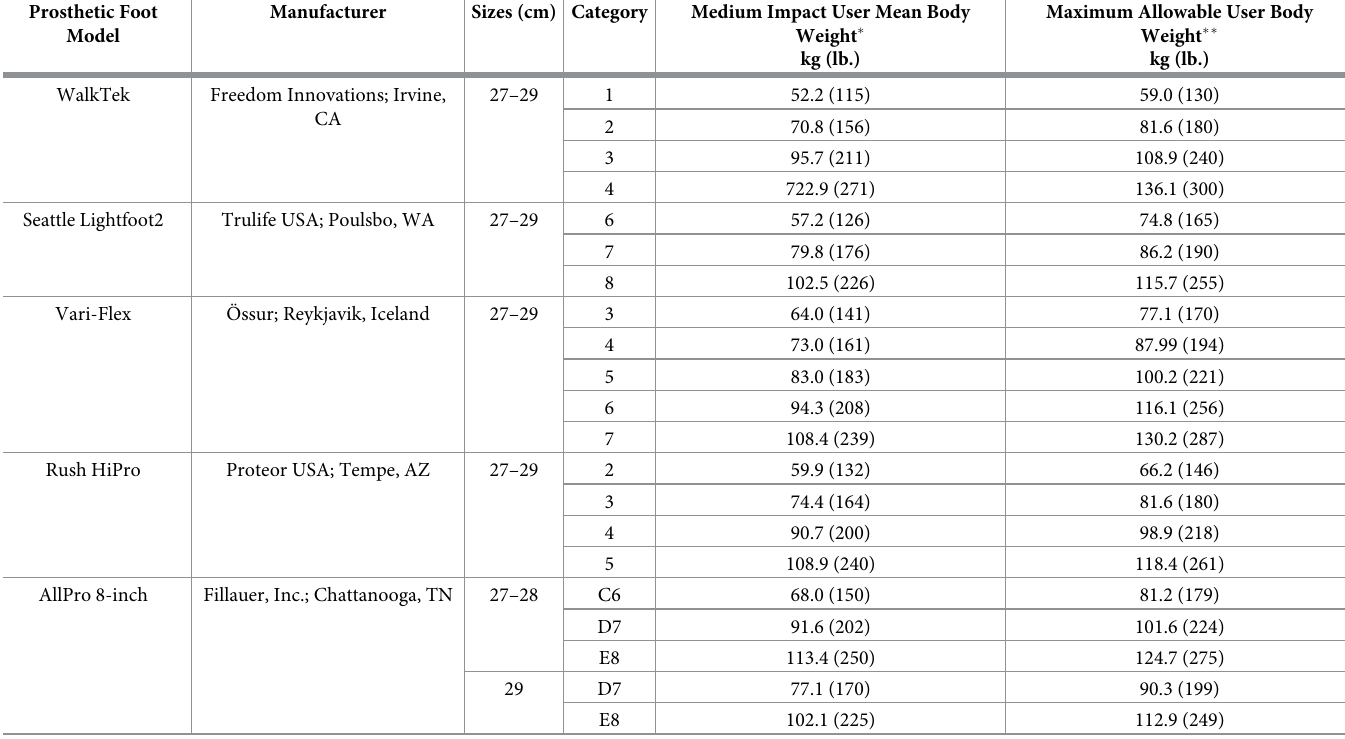
Table 1. Manufacturer-defined stiffness categories for five types of commercial prosthetic